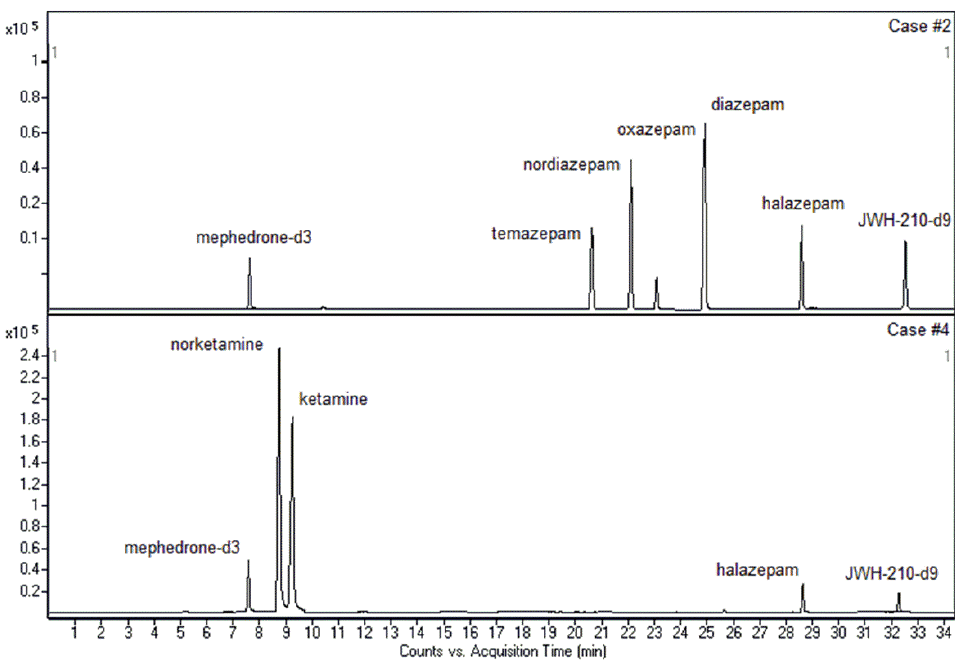
Figure 4. Chromatograms for real case #2 and #4.